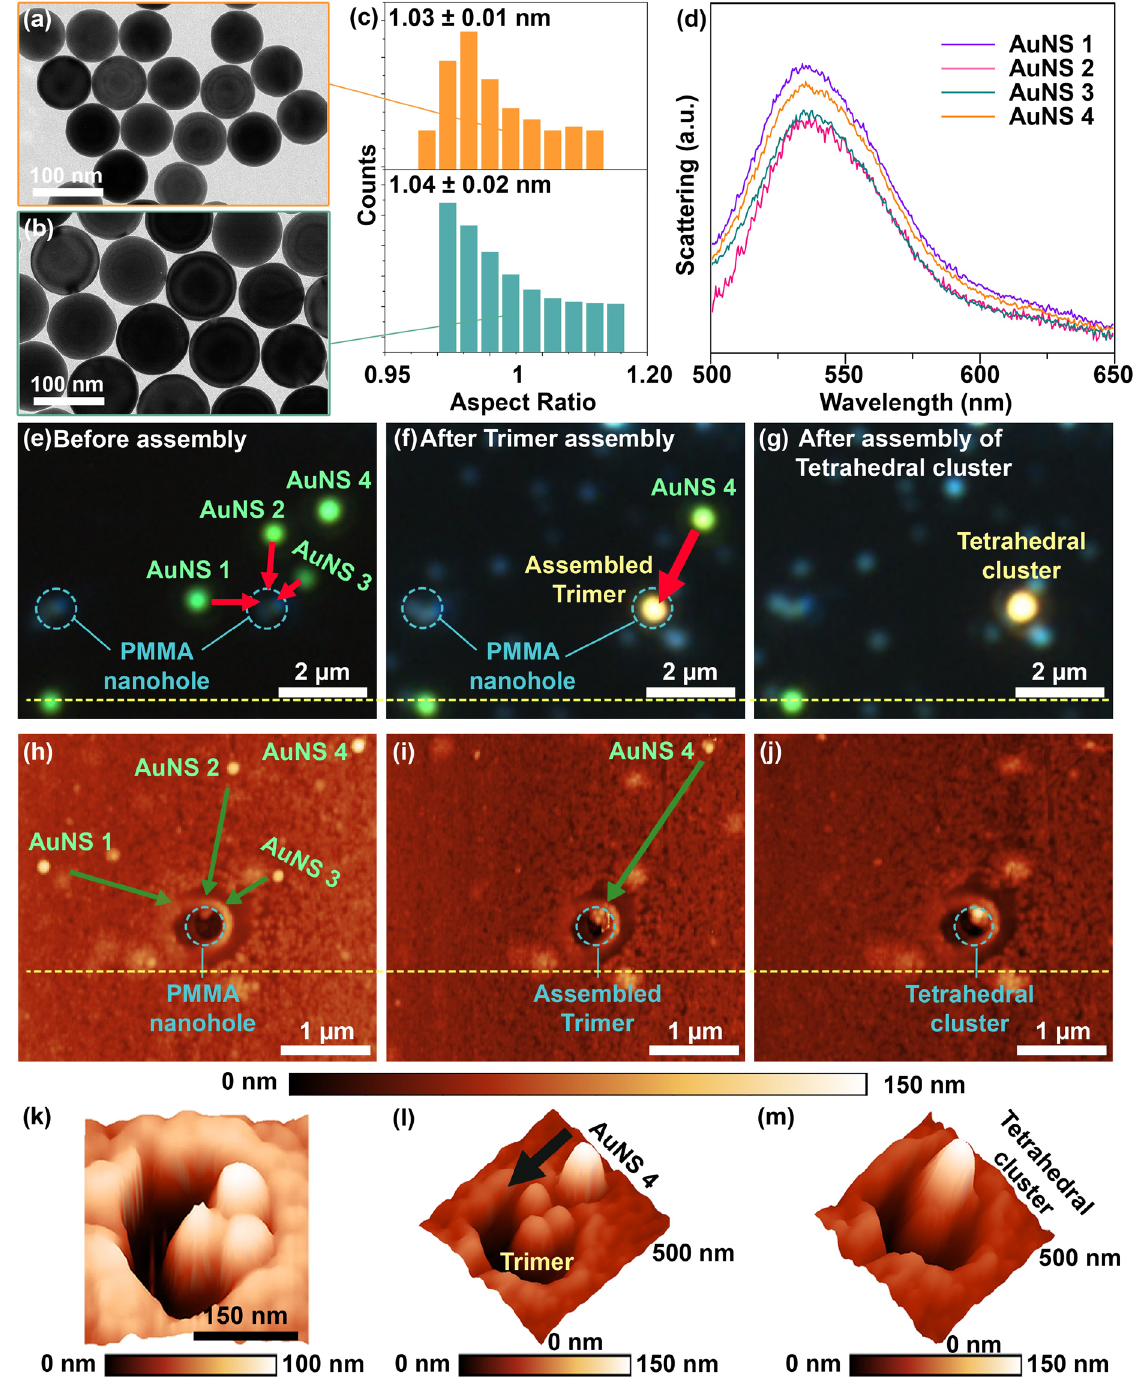
Figure 2. Highly uniform and smooth AuNS and 3D assembly via 2D AFM nanomanipulation. ( a ) Transmission electron microscopy (TEM) image of 77 nm AuNSs. ( b ) TEM image of 100 nm AuNSs. ( c ) Algorithmic analysis of size and shape uniformity of 77 nm (top panel) and 100 nm (bottom panel) AuNSs. Aspect ratio analyses allowed us to quantify the uniformity of AuNSs. ( d ) Dark-field scattering results of 77 nm AuNSs. ( e – g ) Dark-field optical microscope (DFOM) image of the stepwise assembly of 3D plasmonic metamolecules. ( h ) AFM image indicating transfer-printed 77 nm AuNSs and the AFM tip pathway used to assemble the trimer within the PMMA nanohole. ( i ) AFM image highlighting the AFM tip pathway used to push the fourth AuNS to the centroid of the already assembled trimer. ( j ) 2D AFM image of the assembled tetrahedral cluster within PMMA nanohole. ( k ) 3D AFM image of a trimer assembled within the PMMA nanohole. ( l ) 3D AFM images of 4 th AuNS located at the edge of PMMA nanohole. The black arrow highlights the pathway of the fourth AuNS to complete the assembly of the tetrahedral cluster (representative 3D plasmonic metamolecule studied in this work). ( m ) 3D AFM image of the assembled symmetric tetrahedral cluster consisting of equivalent 77 nm